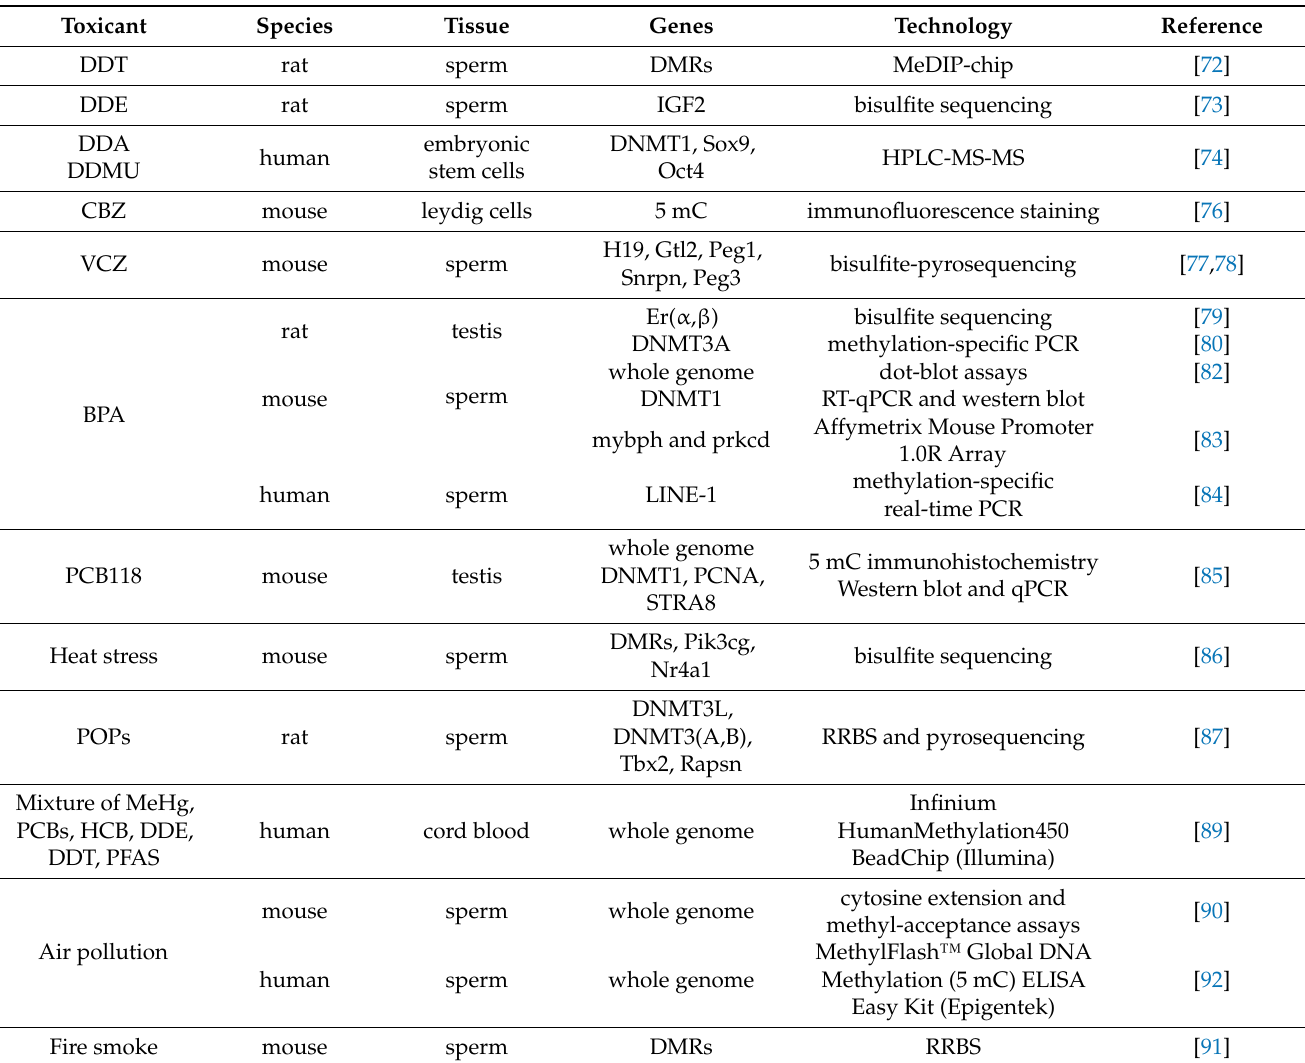
Table 1. Summary of studies on the impact of different toxic substances on male reproductive fitness through DNA